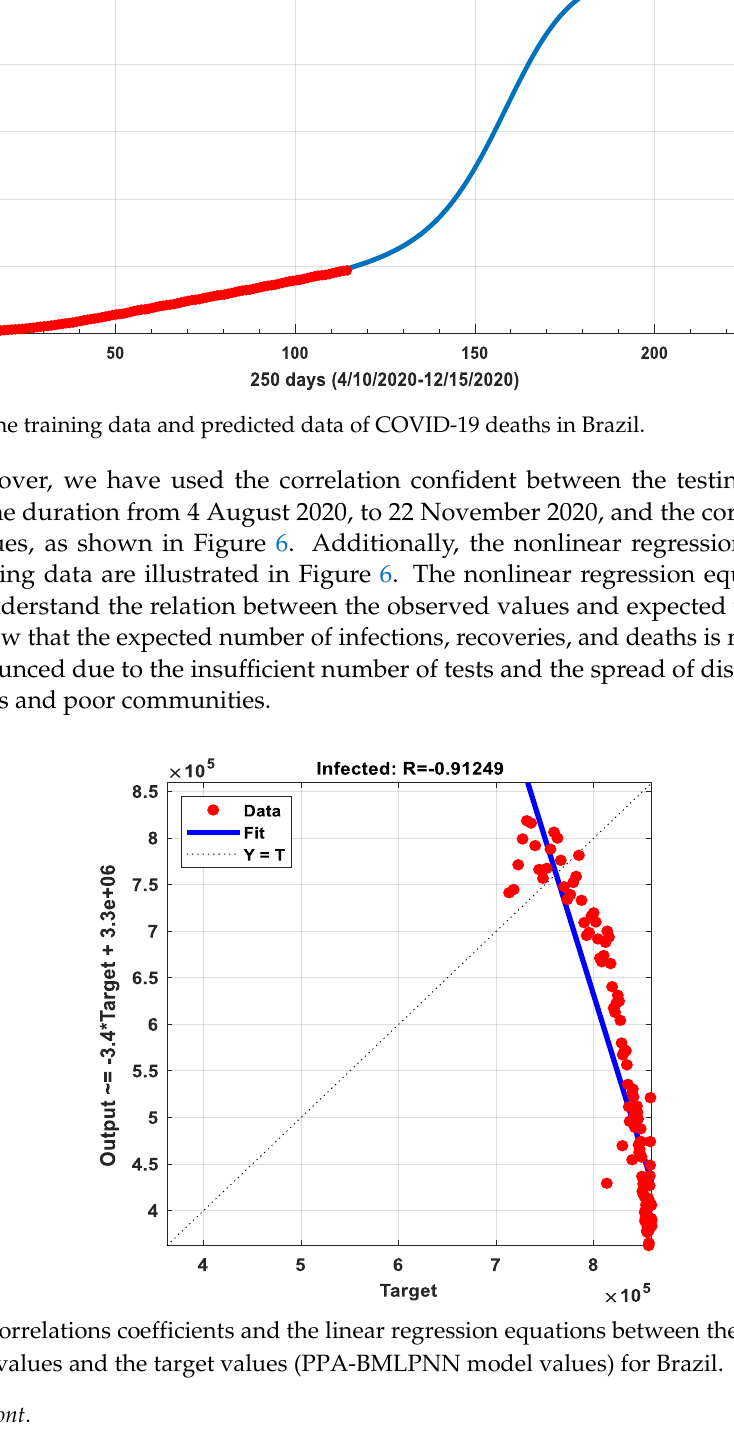
Figure 4. The training data and predicted data of COVID-19 recovered people in Brazil.